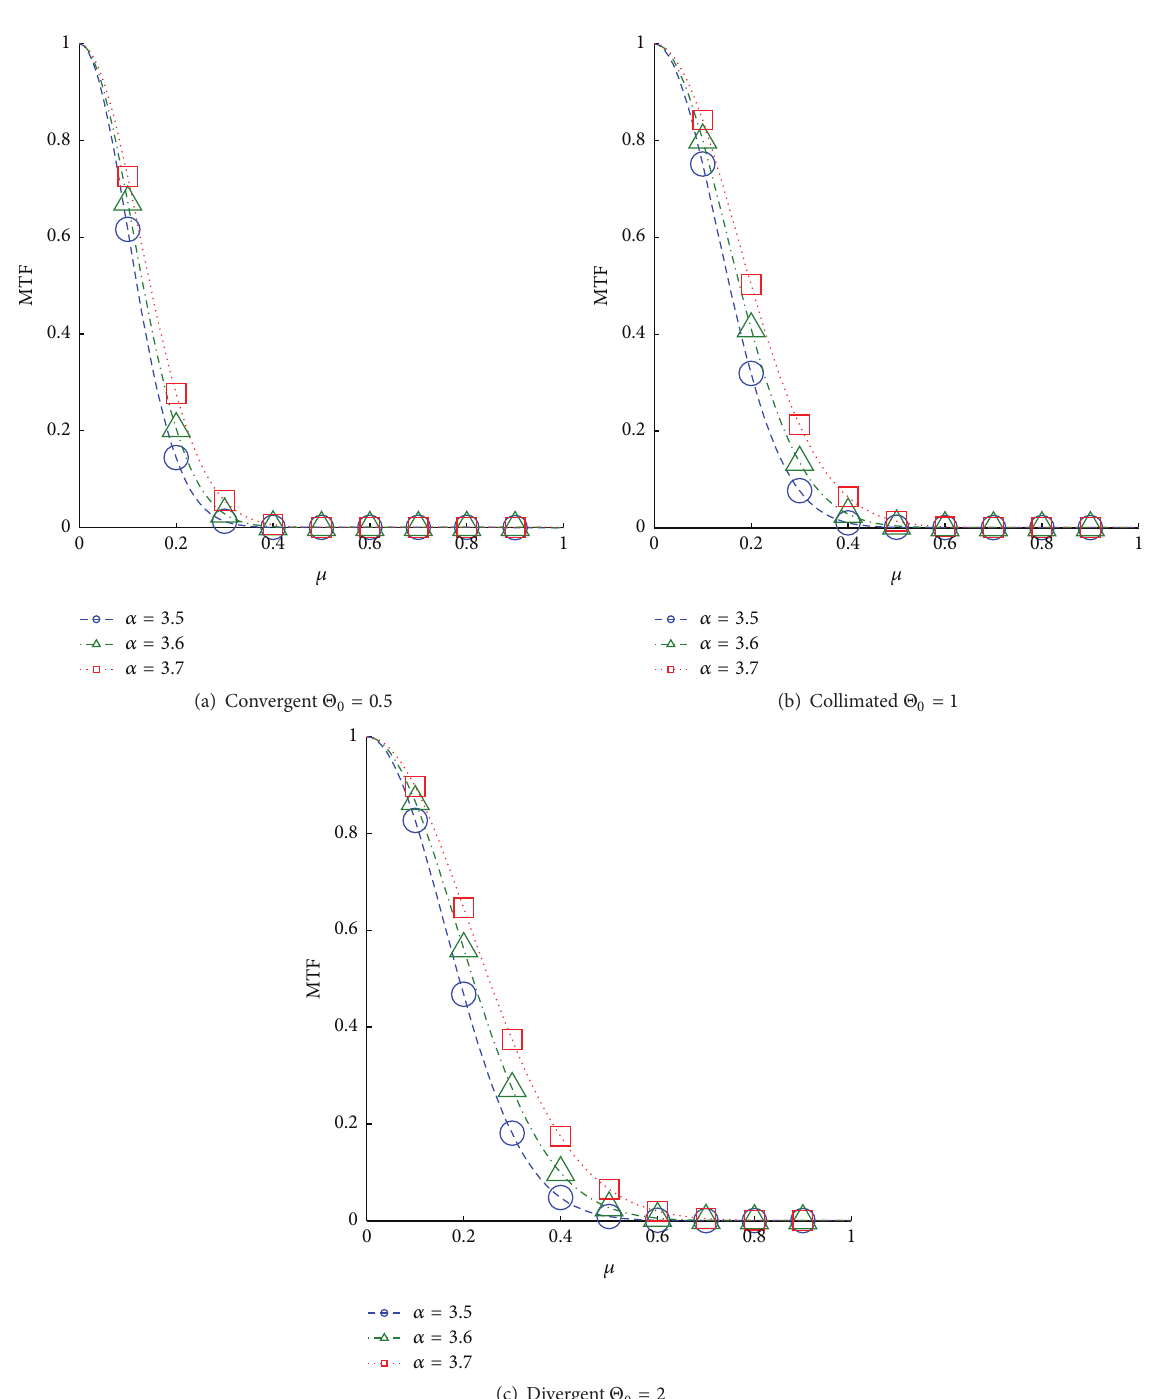
Figure 1: Effects of spectral power law value on MTF for different types of Gaussian